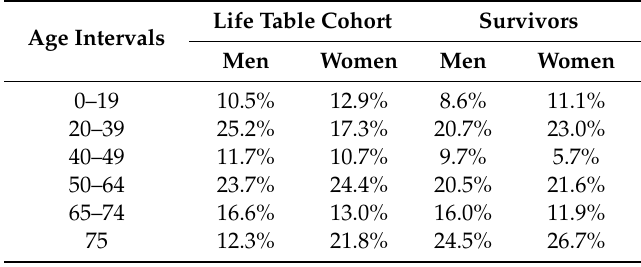
Table 4. Lifetime dental expenditure for life table cohort and survivor men and women by life